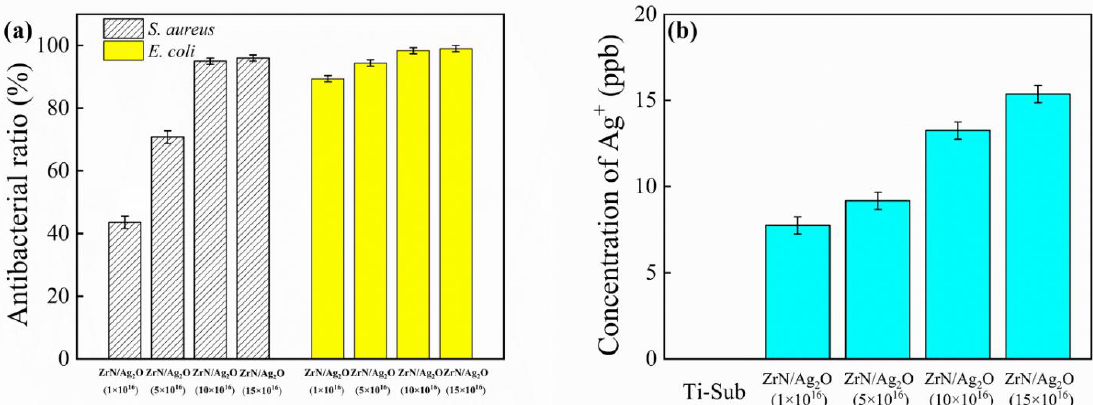
Figure 10. Typical photos of the re-cultivated S. aureus and E. coli colonies on agar for different samples, respectively: ( a 1 ,a 2 ) Ti-substrate; ( b 1 ,b 2 ) ZrN/Ag 2 O (1 × 10 16 ions/cm 2 ); ( c 1 ,c 2 ) ZrN/Ag 2 O (5 × 10 16 ions/cm 2 ); ( d 1 ,d 2 ) ZrN/Ag 2 O (10 × 10 16